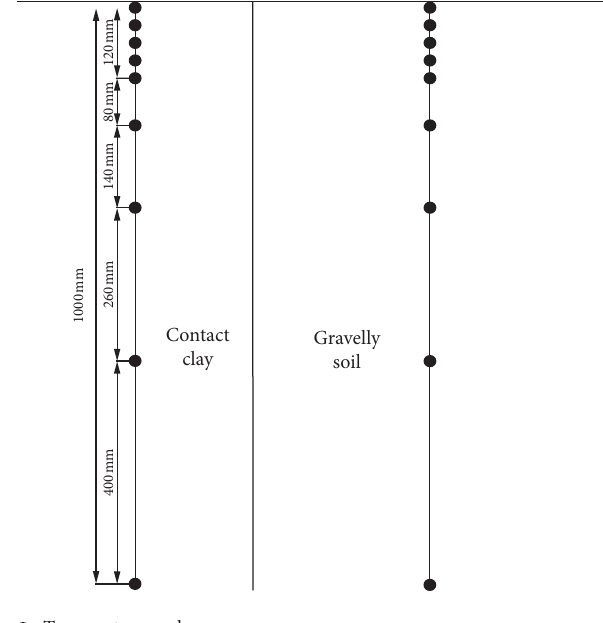
Figure 1: Schematic diagram of the ground temperature obser- vational system.